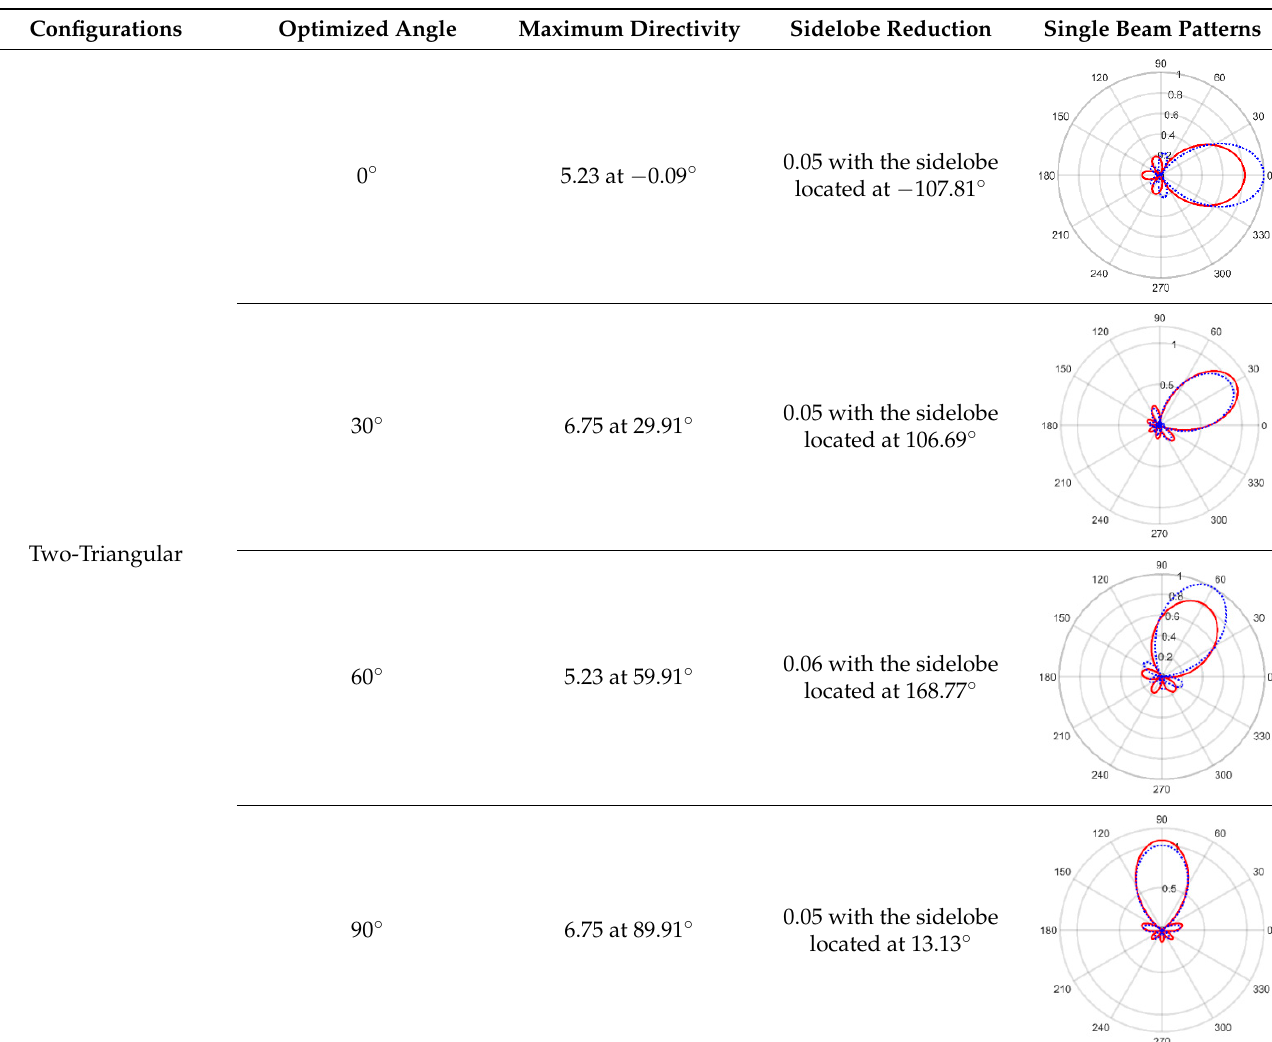
Table 2. Directivity, Sidelobe Reduction and Single Beam Patterns for the newly proposed Array Models, where the blue and read lines are showing the desired beam and optimized beam patterns, respectively.